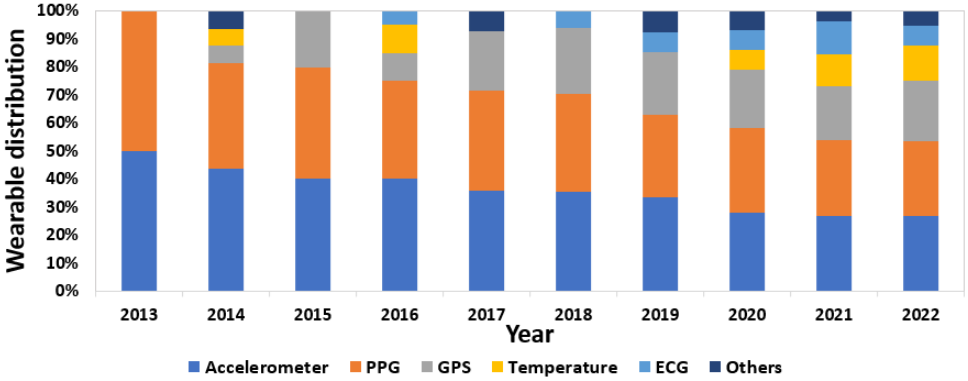
Figure 15. Distribution of sensors used in marketed wearables by year.